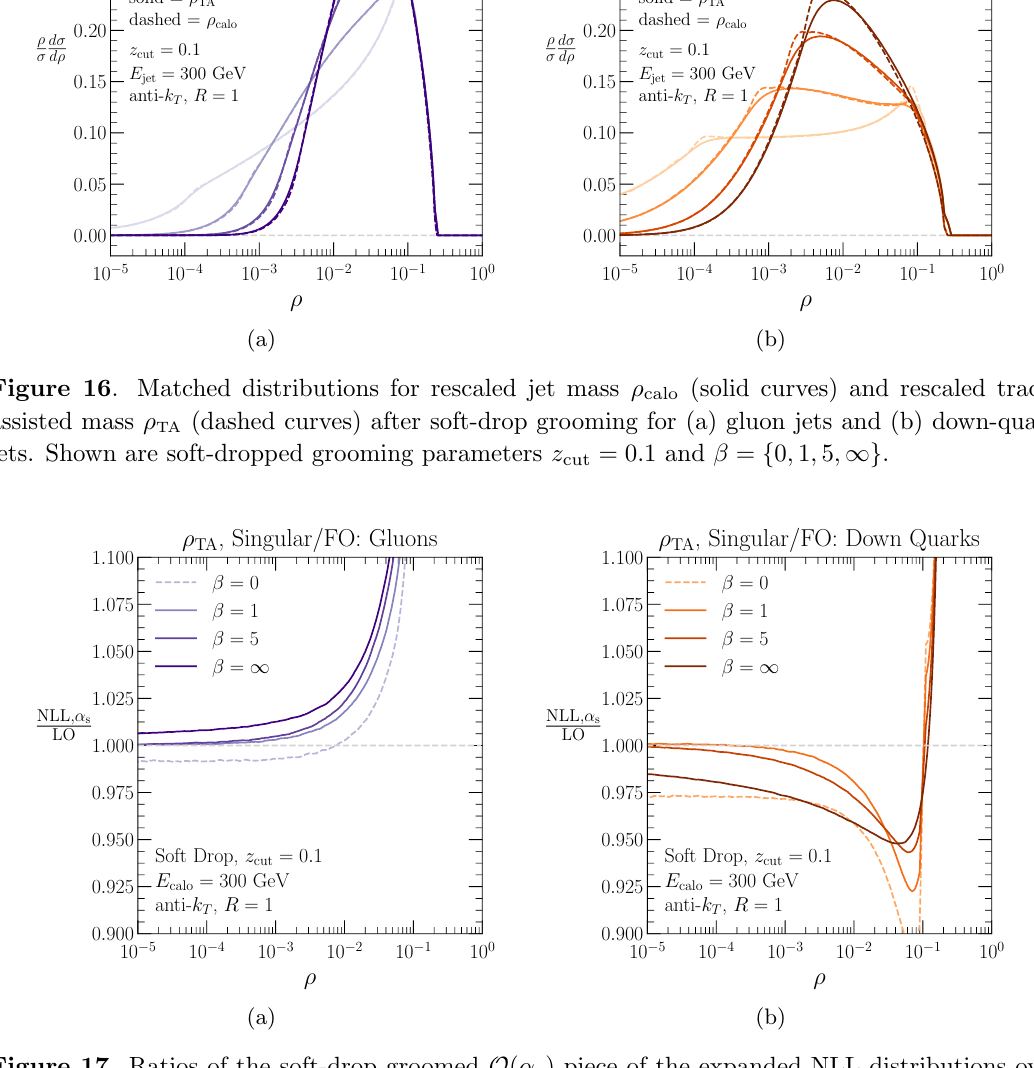
Figure 17 . Ratios of the soft-drop groomed ( (cid:11) s ) piece of the expanded NLL distributions over O the LO (cid:26) distributions. The (cid:12) = 0 case is dashed since this calculation is formally only LL order. TA In (cid:12)gure 17, we again plot the ratio of the ( (cid:11) s ) piece of the resummed distribution O over the (cid:12)xed-order distribution, this time for groomed jets with R = 1, z cut = 0 : 1, and (cid:12) = 0 ; 1 ; 5 ; . For (cid:12) = , we recover the R = 1 result from (cid:12)gure 10. With (cid:12) = f 1g 1